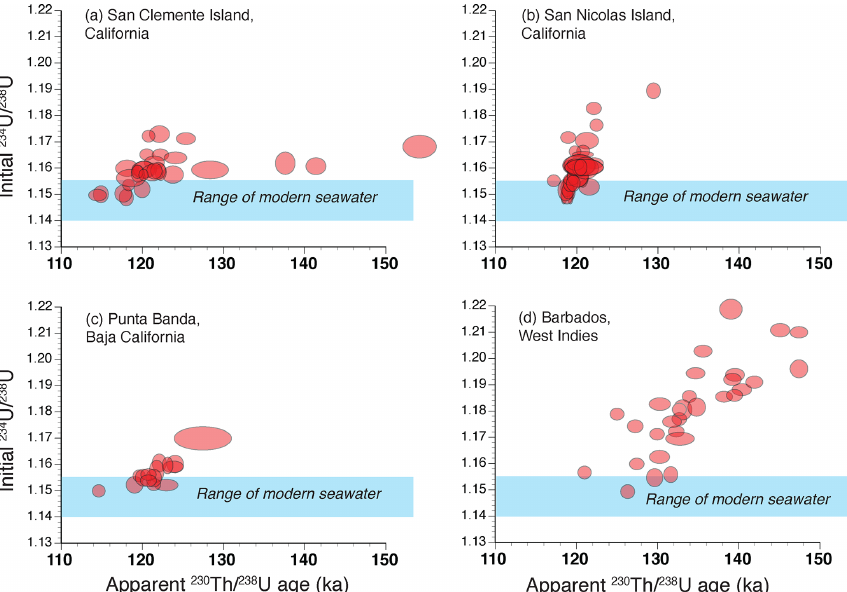
Figure 10. Plots of apparent 230 Th / 238 U ages vs. back-calculated initial 234 U / 238 U values in solitary corals from (a) Eel Point terrace, San Clemente Island, California, (b) Terrace 2, west end of San Nicolas Island, California (same as in Fig. 9b but with different scales), (c) Sea Cave terrace, Punta Banda, Baja California, Mexico, and (d) colonial corals (mostly Acropora palmata ) from the Rendezvous Hill terrace, north end of Barbados, West Indies. San Clemente Island and Punta Banda data are from Muhs et al. (2002b), San Nicolas Island data are from Muhs et al. (2006), and Barbados data are from Muhs and Simmons (2017). Also shown (blue bands) is the range of 234 U / 238 U activity values in modern seawater (Chen et al., 1986; Delanghe et al., 2002). Note that in both solitary corals and colonial corals, samples plotting above seawater values tend to be biased to older apparent ages, but the degree of bias varies from locality to